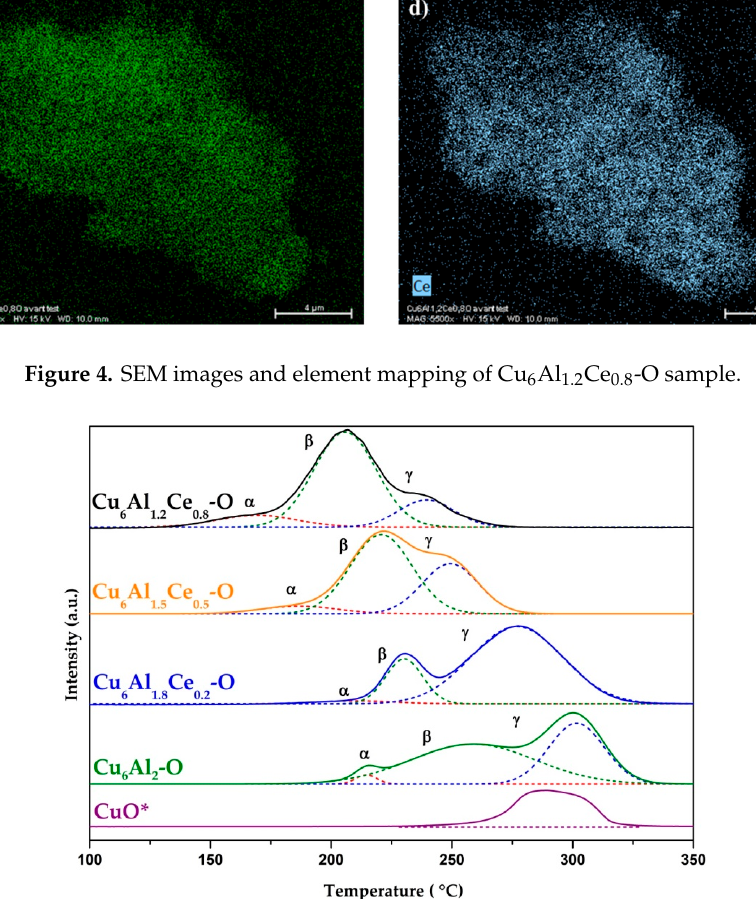
Figure 4. SEM images and element mapping of Cu 6 Al 1.2 Ce 0.8 -O sample.